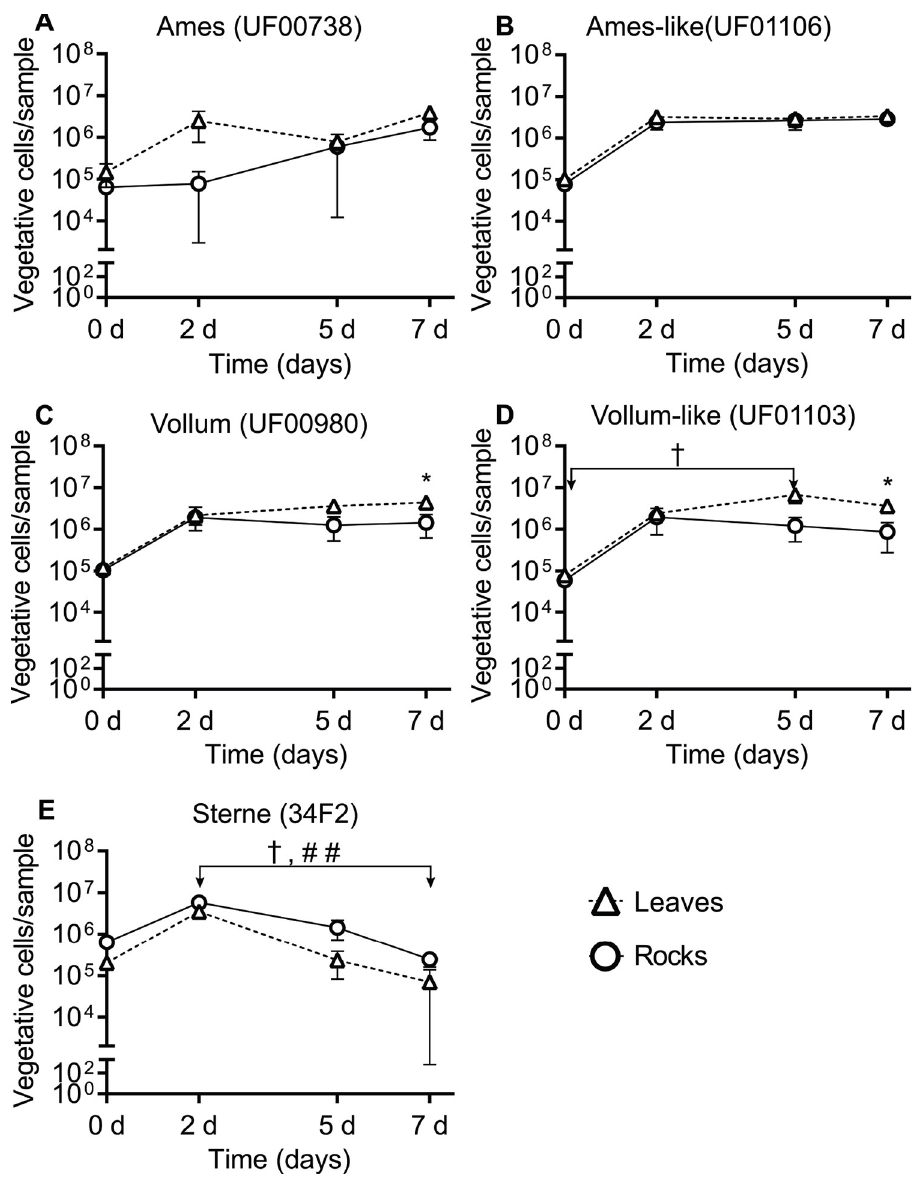
Fig 3. Bacillus anthracis vegetative cell viability on leaf and rock surfaces over a 7-day period. The number of vegetative cells recovered from leaves (triangles) and rocks (circles) are reported for (A) Ames (UF00738), (B) Ames- like (UF01106), (C) Vollum (UF00980), (D) Vollum-like (UF01103), and (E) Sterne (34F2), illustrating vegetative cell persistence for at least 7 dpi. Results are shown as the mean ± SEM and graphed on a log scale. Significance between days for each strain was determined by Kruskal-Wallis and Dunn’s multiple comparisons tests with leaf temporal differences identified by † = ρ < 0.05 and rock temporal differences identified by # = ρ < 0.05, ## = ρ < 0.01. Significance between surface types on a single day were determined by Mann-Whitney U tests with � = ρ <